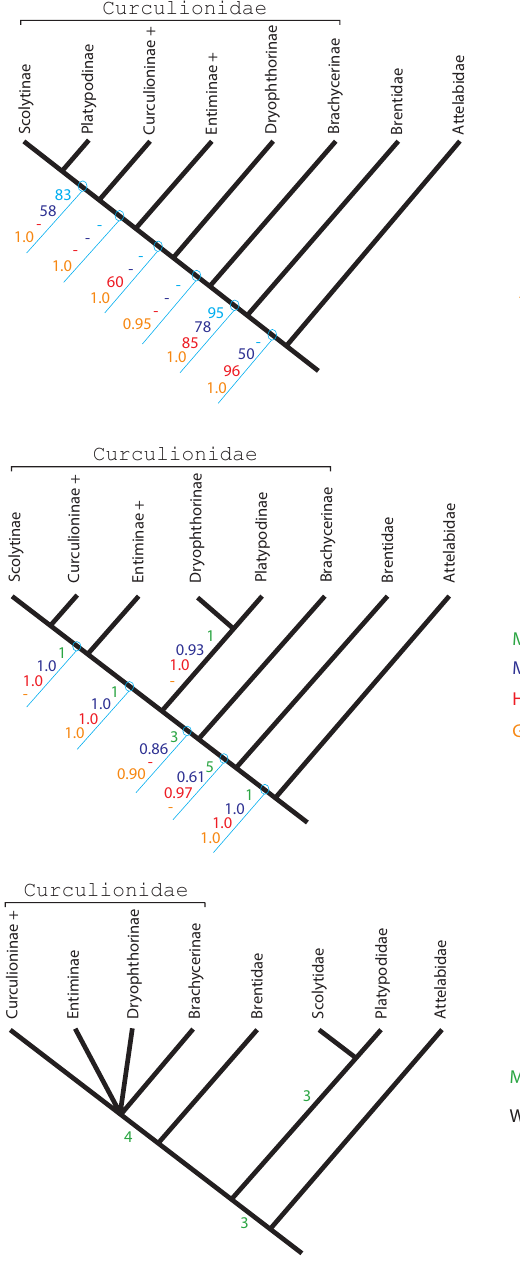
Figure 1. Three alternative phylogeny-based classifications. Numbers on nodes indicate support val- ues according to the method reported in the publication listed in the same colour to the right. Low integers (1-9) indicate Bremer support or number of apomorphic characters, higher integers (>50) indicate parsimony bootstrap support, and proportions (>0.50) indicate posterior probabilities from Bayesian